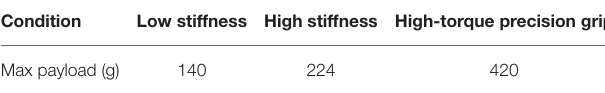
TABLE 2 | The result of the gripping test under three